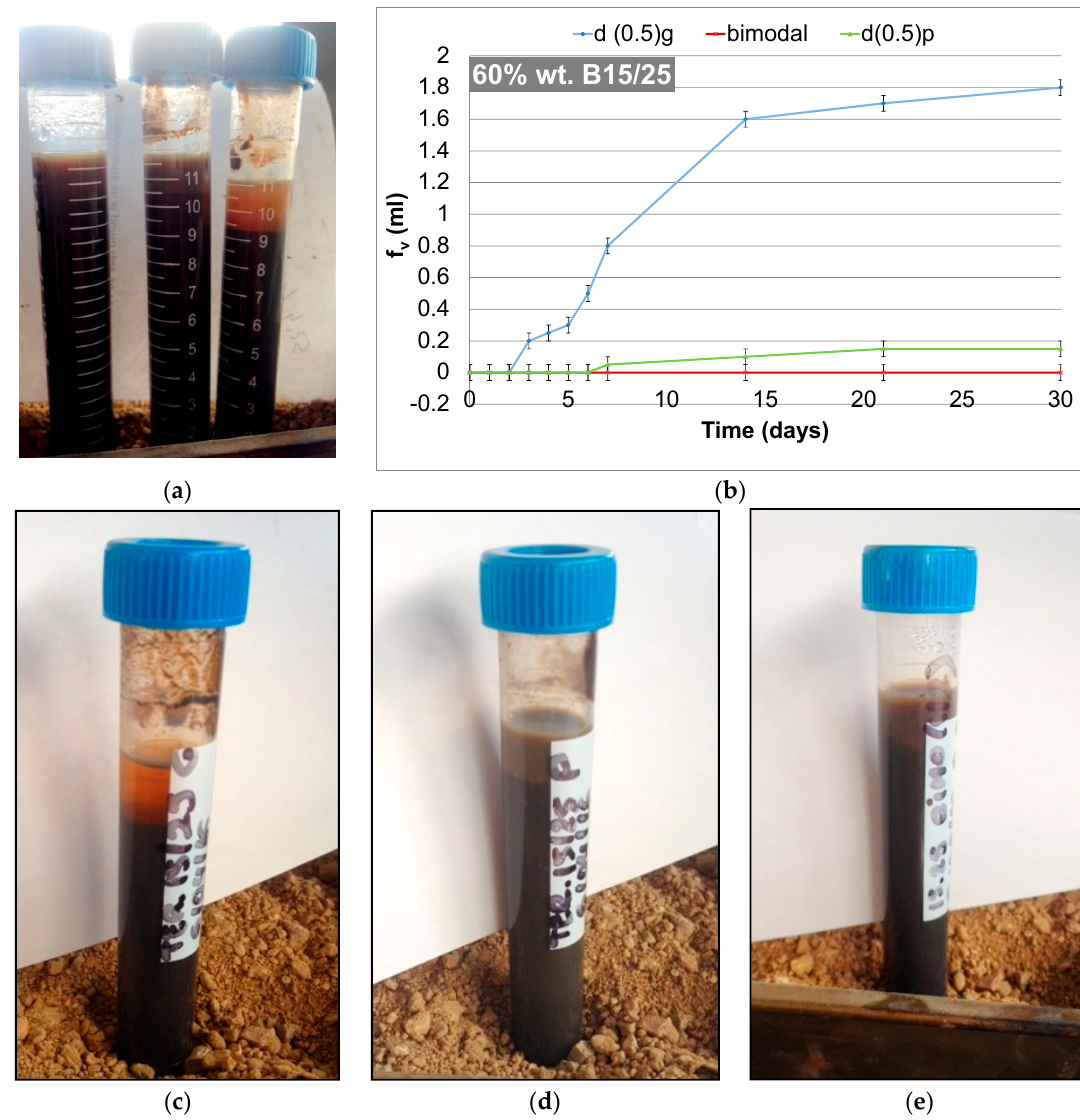
Figure 10. Emulsions of 60 wt. % B15/25: ( a ) global vision; ( b ) sedimentation curve; ( c ) monomodal d(0.5) l ; ( d ) monomodal d(0.5) s ; ( e ) bimodal emulsion.